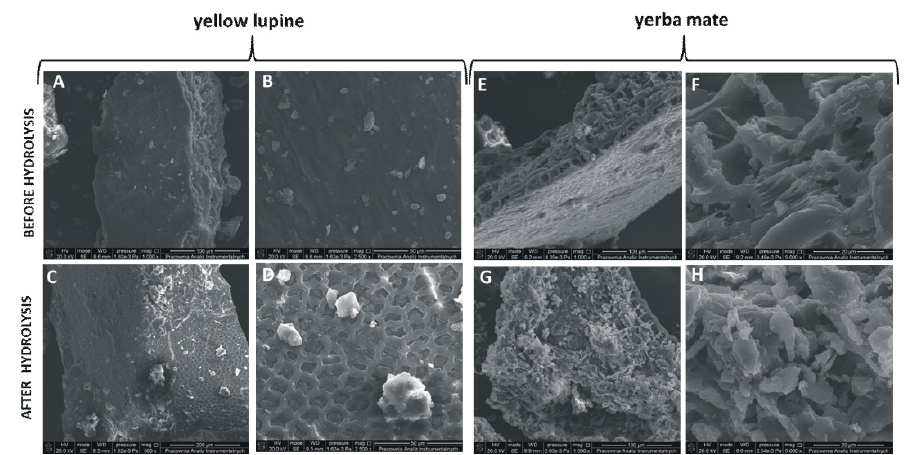
Figure 4. Comparison of the ultrastructure of yellow lupine plant material ( A – D ) and yerba mate plant material ( E – H ) before and after hydrolysis with Kemzyme ®